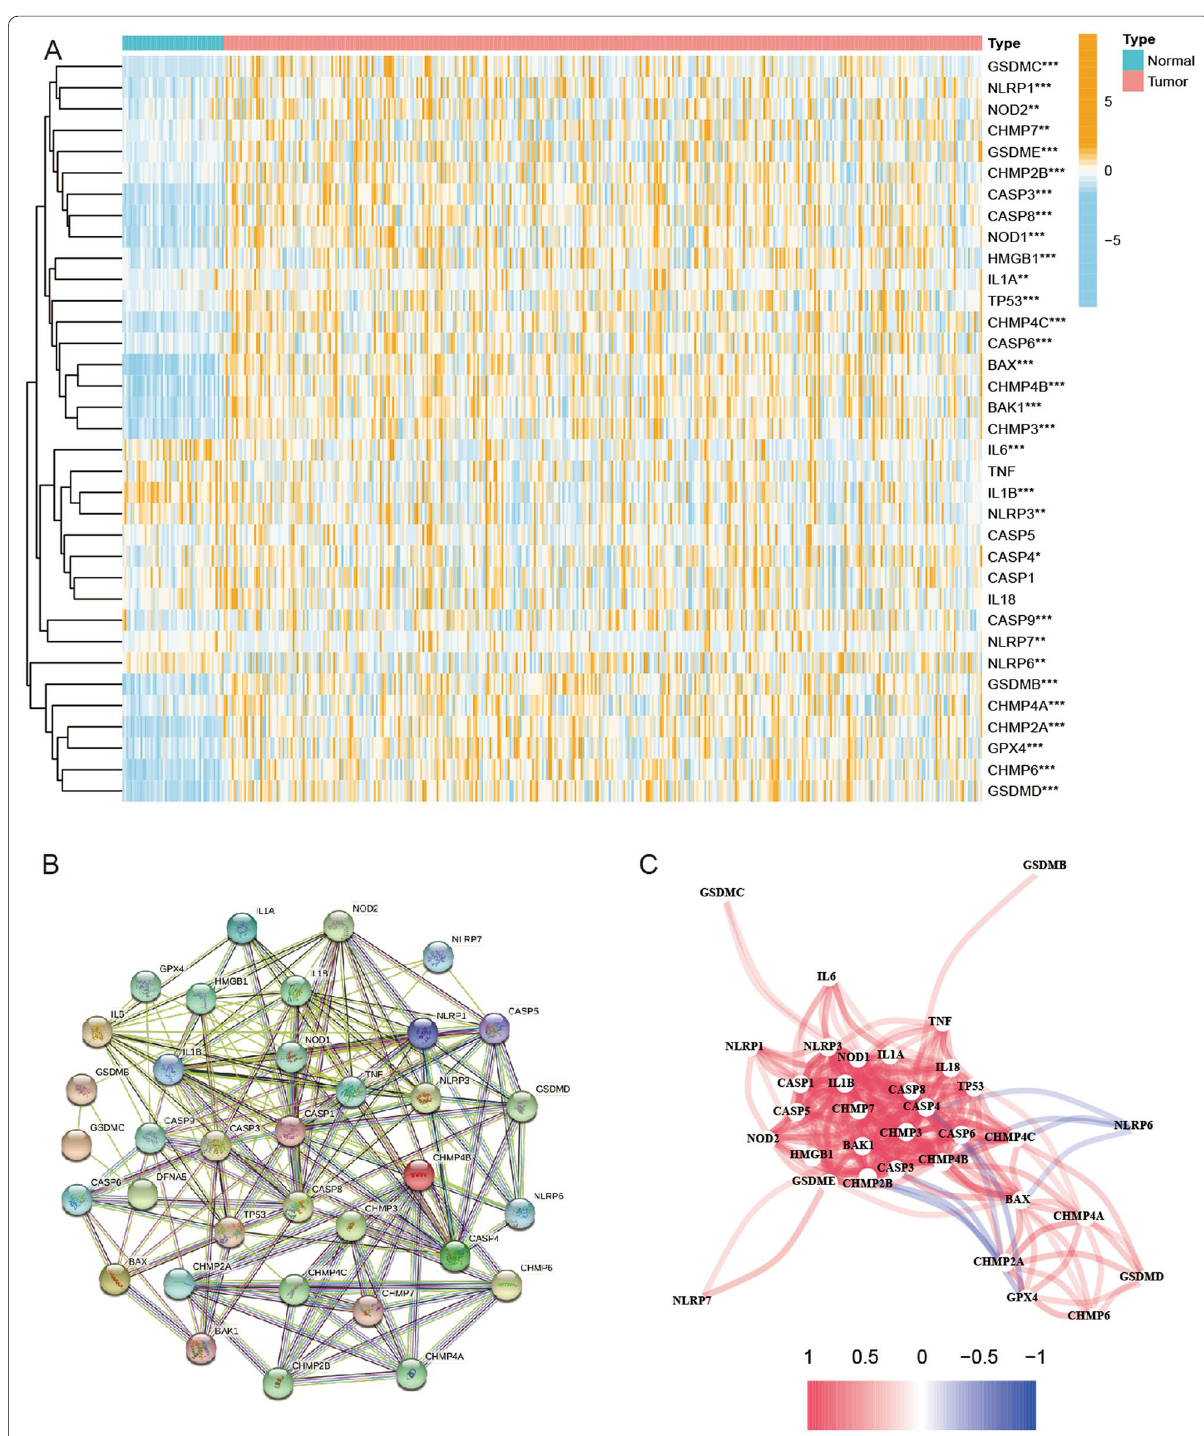
Fig. 1 Expression of the 35 PRGs and the interactions among them. A Heatmap (blue: low expression level; orange: high expression level) of the PRGs between the nontumor (N, blue) and tumor samples (T, red). P values were shown as: **p < 0.01; ***p < 0.001. B PPI network showing the interactions of the PRGs (interaction score 0.4). C The correlation network of the PRGs (red line: positive correlation; blue line: negative correlation. = The depth of the colors reflects the strength of the